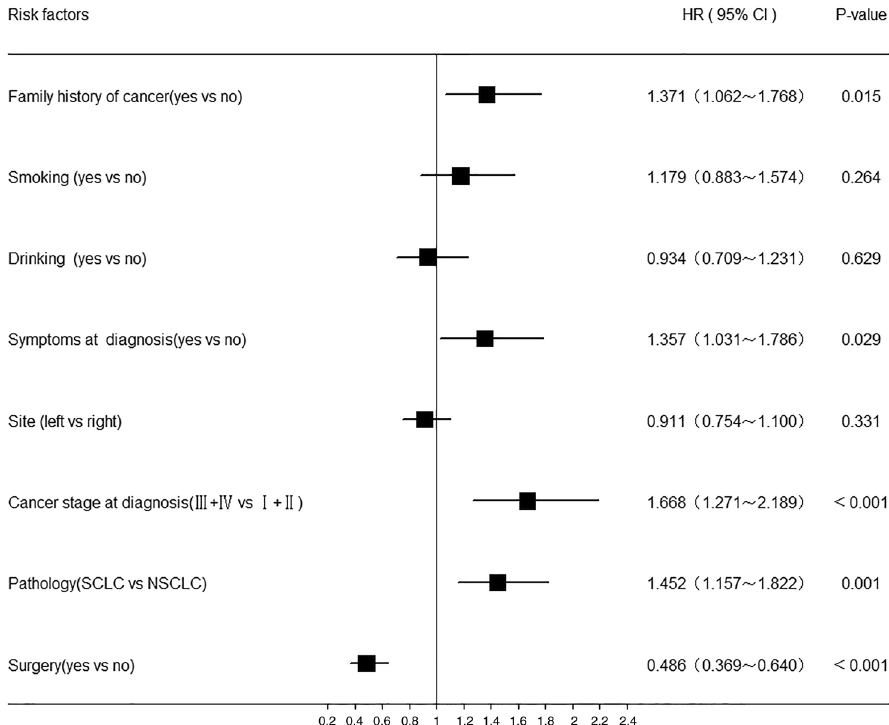
symptoms, site, cancer stage at diagnosis, pathology and